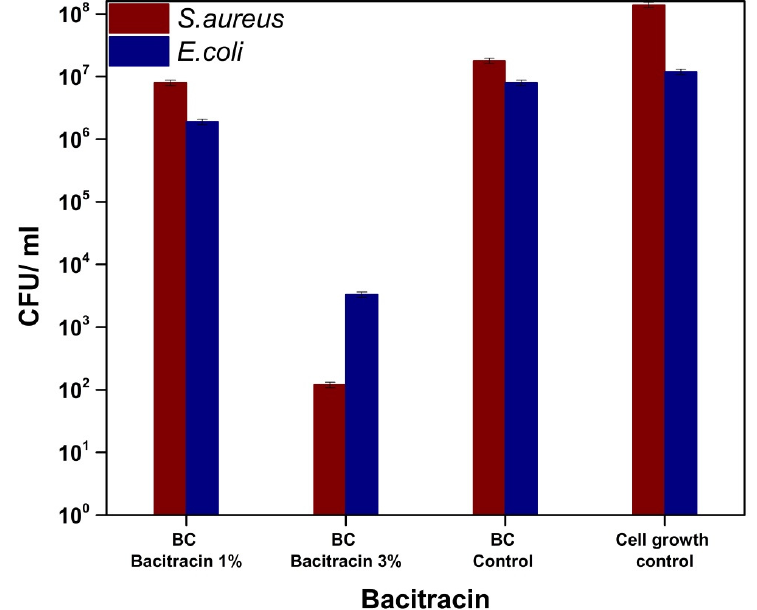
Figure 9. Graphical representation of CFU / mL values of Staphylococcus aureus ATCC 25923 and Escherichia coli ATCC 25922, in order to evaluate the capability of the bacterial cells to adhere on the surface of BC-bacitracin samples.